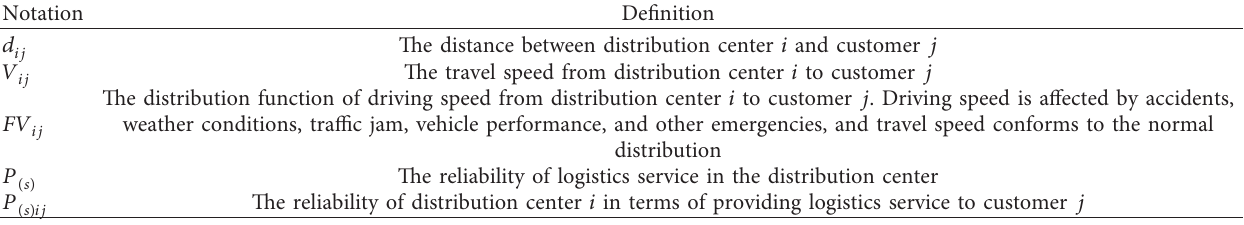
Figure 2: Membership function diagram of triangular and trapezoidal fuzzy numbers. (a) Graph of triangular fuzzy membership function. (b) Diagram of trapezoidal fuzzy membership function. Table 1: Symbol of logistics service